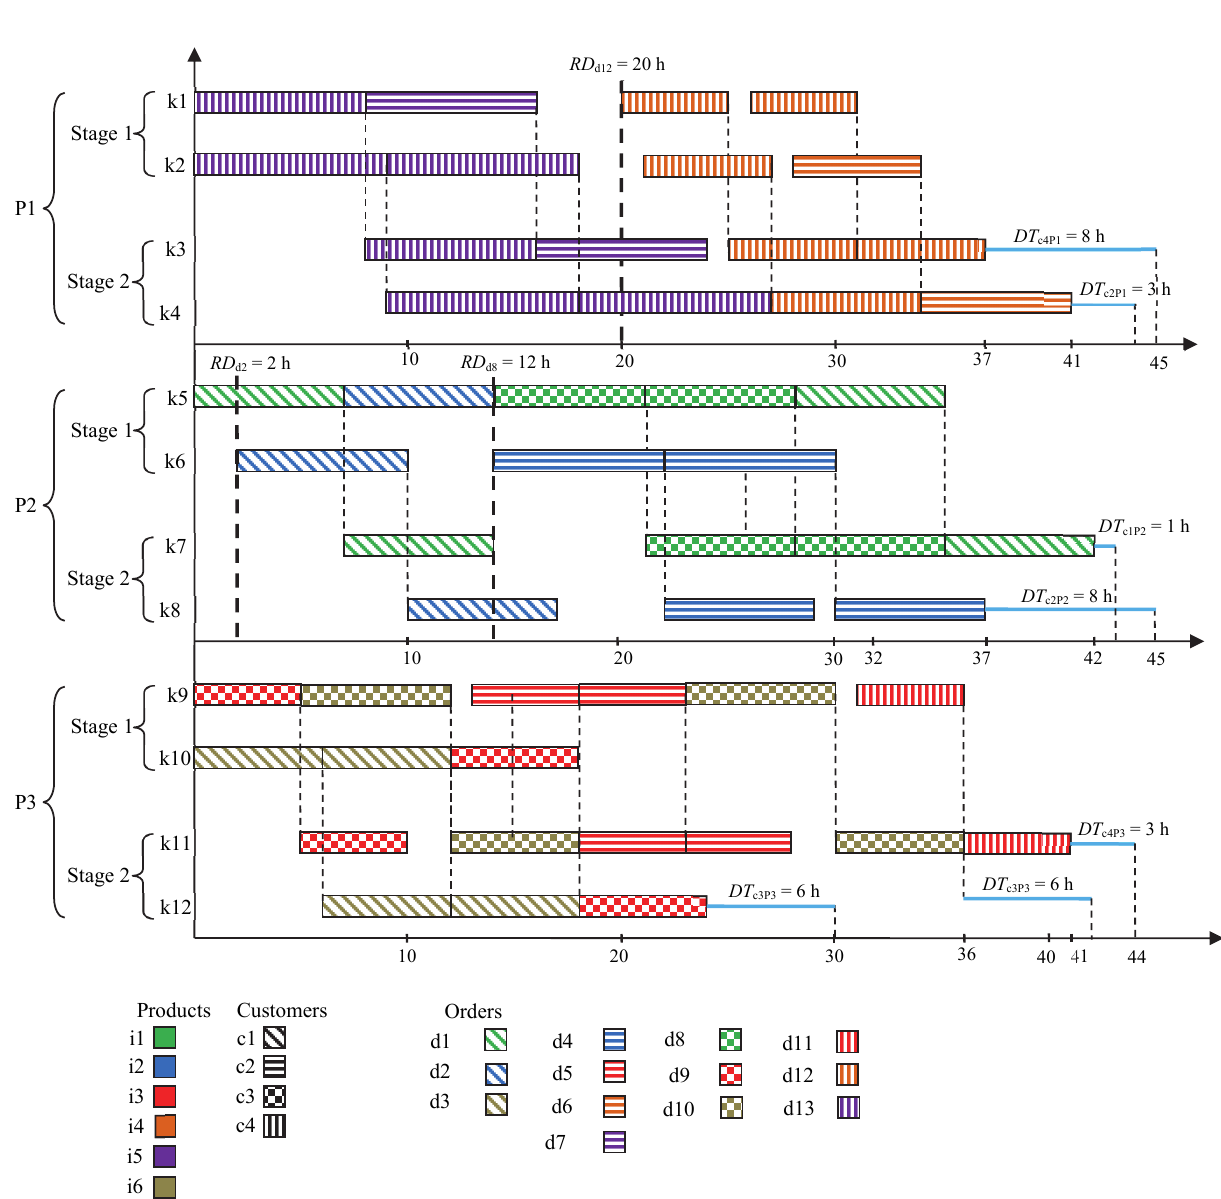
Fig. 7. Gantt chart for coordination policy of Example